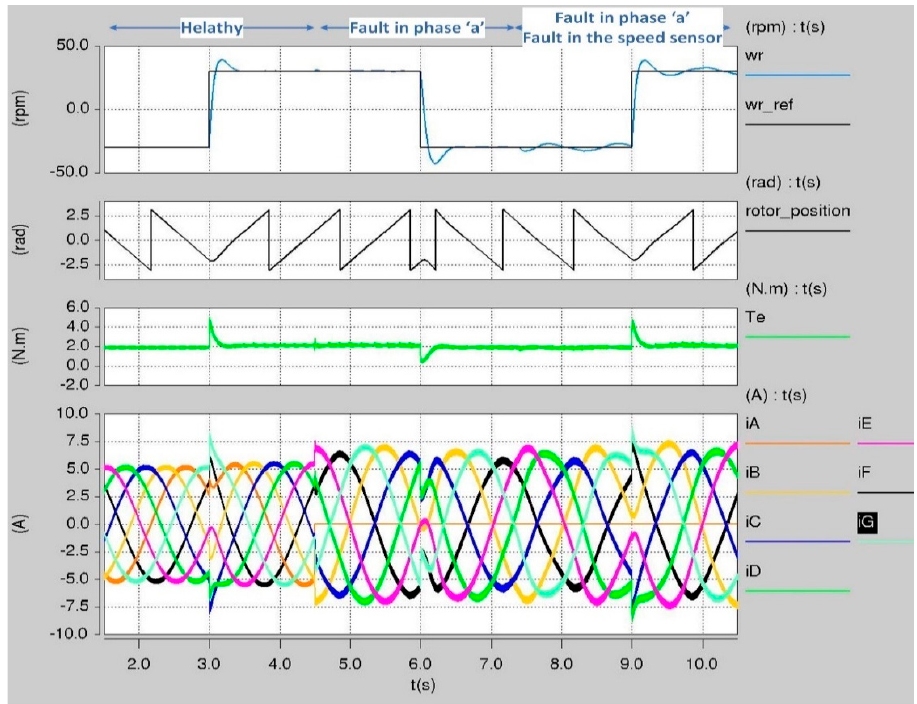
Figure 19. Low speed steps of the seven ‐ phase drive post the failures in speed sensor and in phase